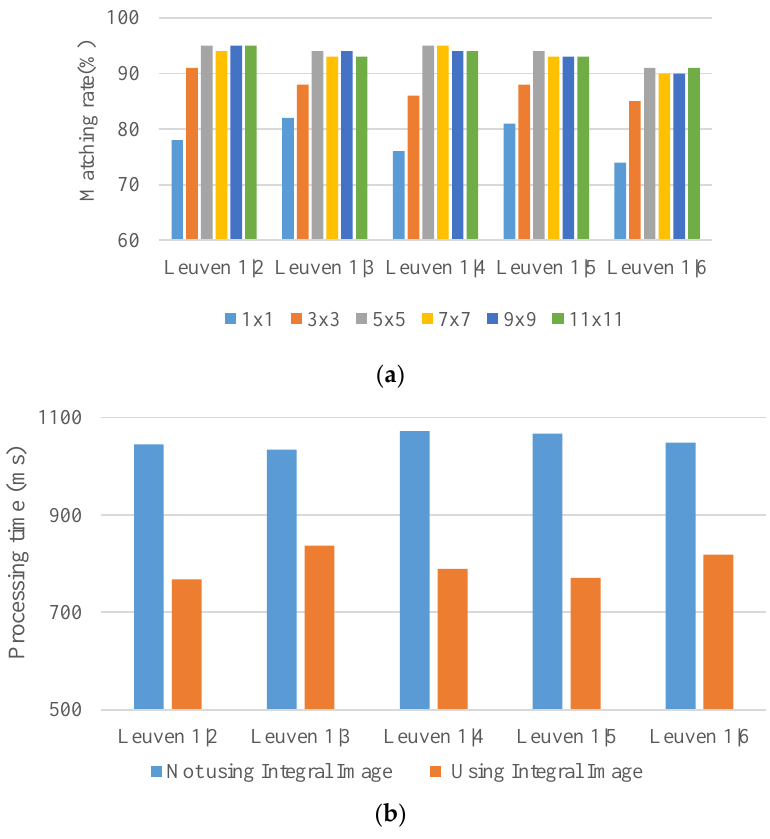
Figure 11. Matching rate and calculation time comparison between with and without the use of integral image. ( a ) Matching rate achieved through Gaussian weighting templates of various sizes; ( b ) Calculation time required for the Gaussian weighting templates when the integral image is